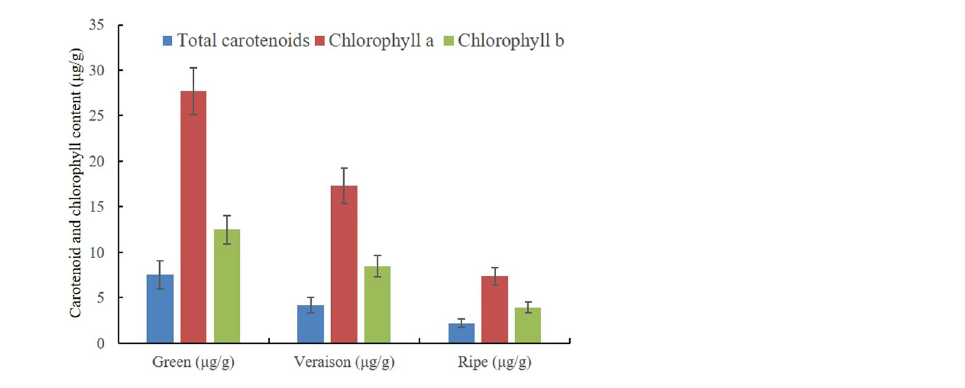
Figrue 4. Total carotenoid and chlorophyll content during grapevine fruit